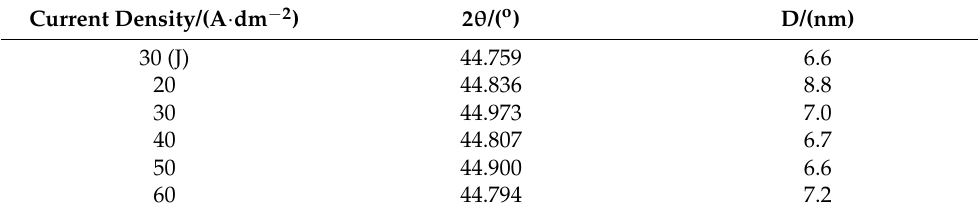
Figure 6. XRD pattern of Ni–P alloy coatings. Table 4. Grain size of Ni(111) element in Ni–P